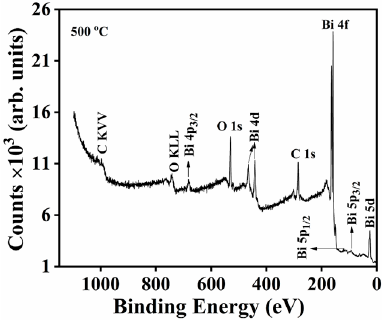
Figure 12. XPS survey spectra of Bi 2 O 3 :Ho 3+ thin film at a substrate temperature of 500 °C.